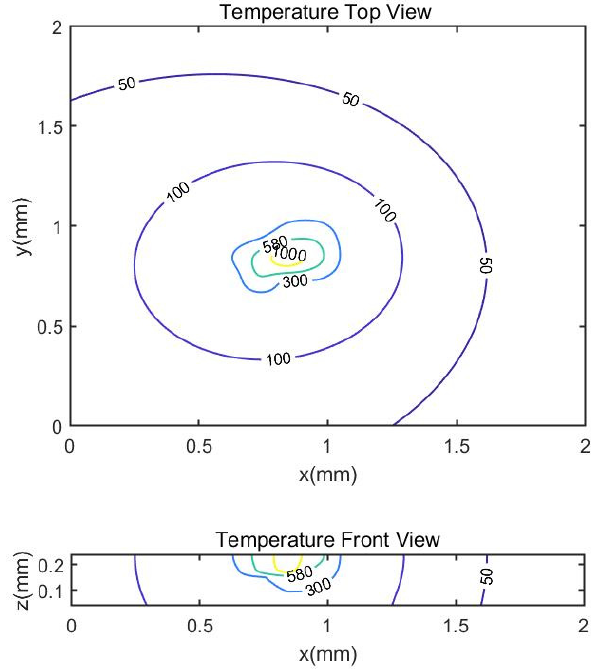
Figure 4. Predicted temperature profile in top and front view with laser power 400 W, scan speed 1000 mm/s, hatching space 200 μ m and layer thickness 60 μ m. The rotation angle between two successive layers is 67 degrees.